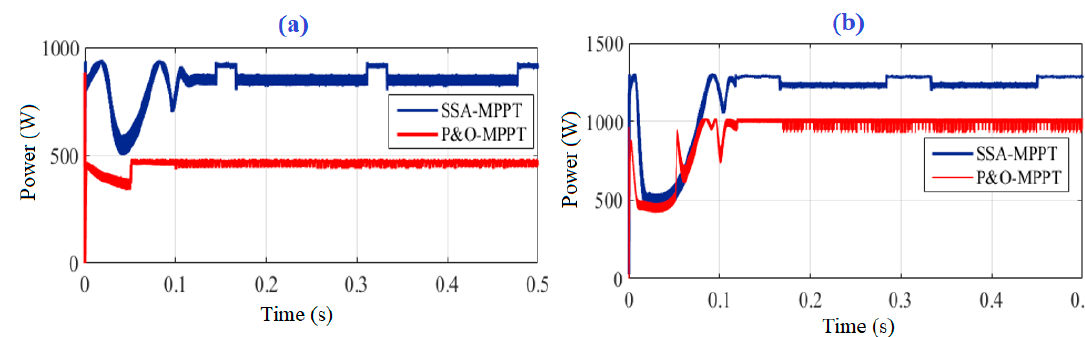
Figure 8. The response of PV output power for SSA and perturb and observe (P&O) MPPT ( a ) first scenario ( b ) second scenario.